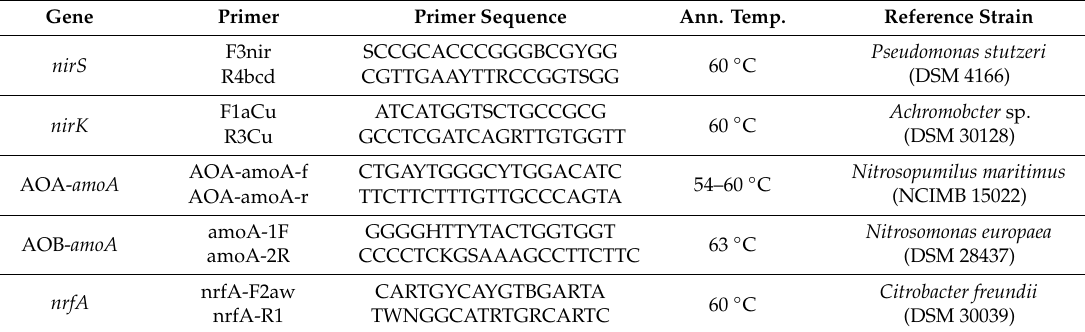
Table 1. List of primers, strains and annealing temperatures used in this study. AOA—ammonia oxidizing archaea, AOB—ammonia oxidizing